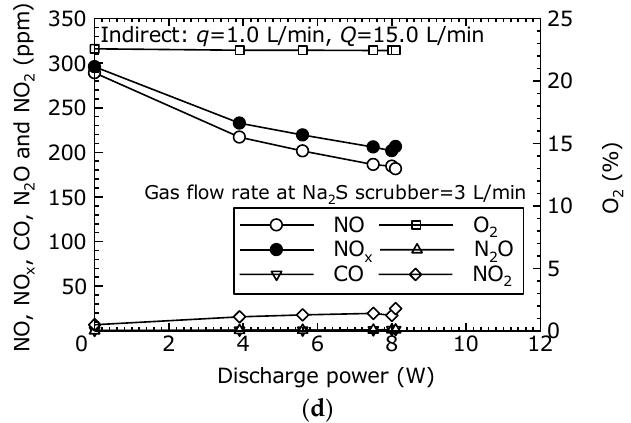
Figure 8. Gas concentrations in dry plasma and wet chemical processes by the indirect oxidation method. (( a ) Q = 3 L/min, ( b ) Q = 5 L/min, ( c ) Q = 10 L/min and ( d ) Q = 15 L/min).